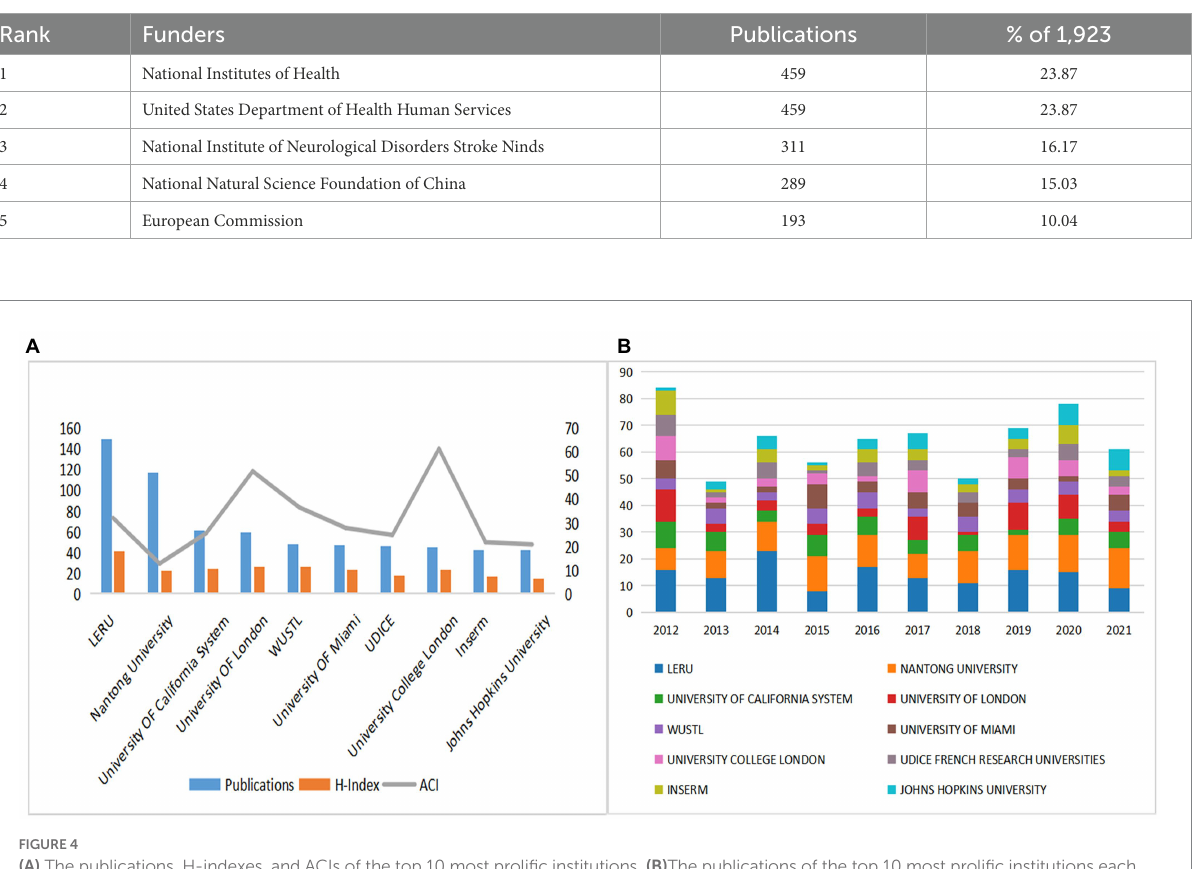
TABLE 1 Top 5 prolific funders.